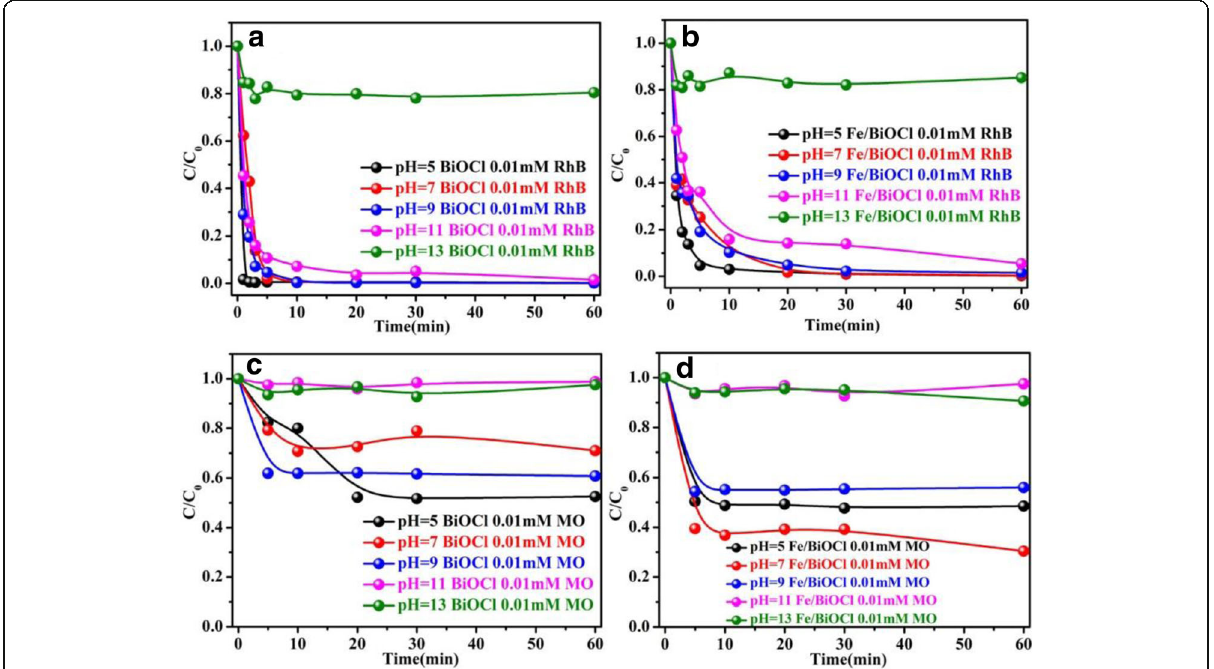
Fig. 9 Effect of pH value on adsorption capacities of BiOCl and Fe/BiOCl toward RhB ( a , b ) and MO ( c , d ) (temperature = 25 °C, initial concentration = 0.01